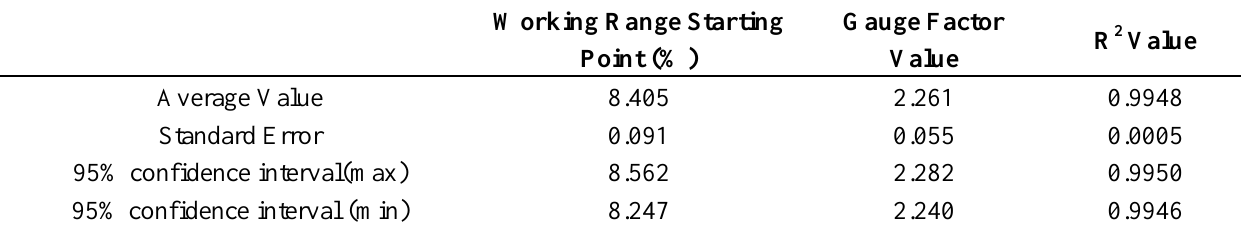
Table 10. Statistical results of samples realised with six conductive